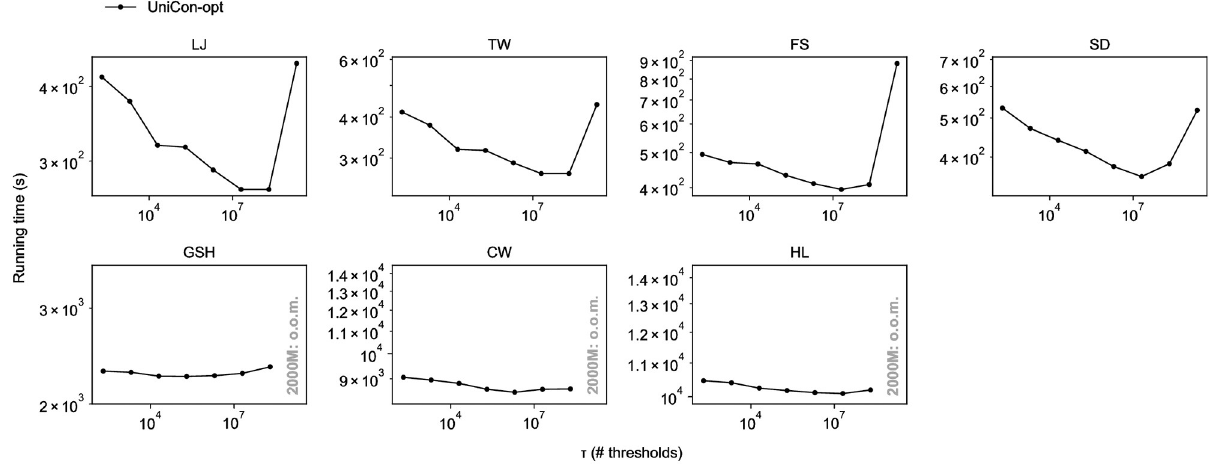
Fig 6. The running time of UniCon-opt on various τ .